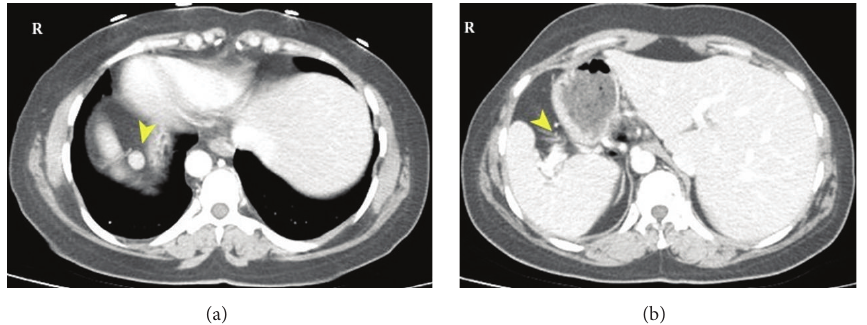
Figure 1: Abdomen CT; mirror view of intra-abdominal organs due to situs inversus, accessory spleen (arrow head (a)), and no pancreatic tissue in splenic hilum (arrow head (b)).